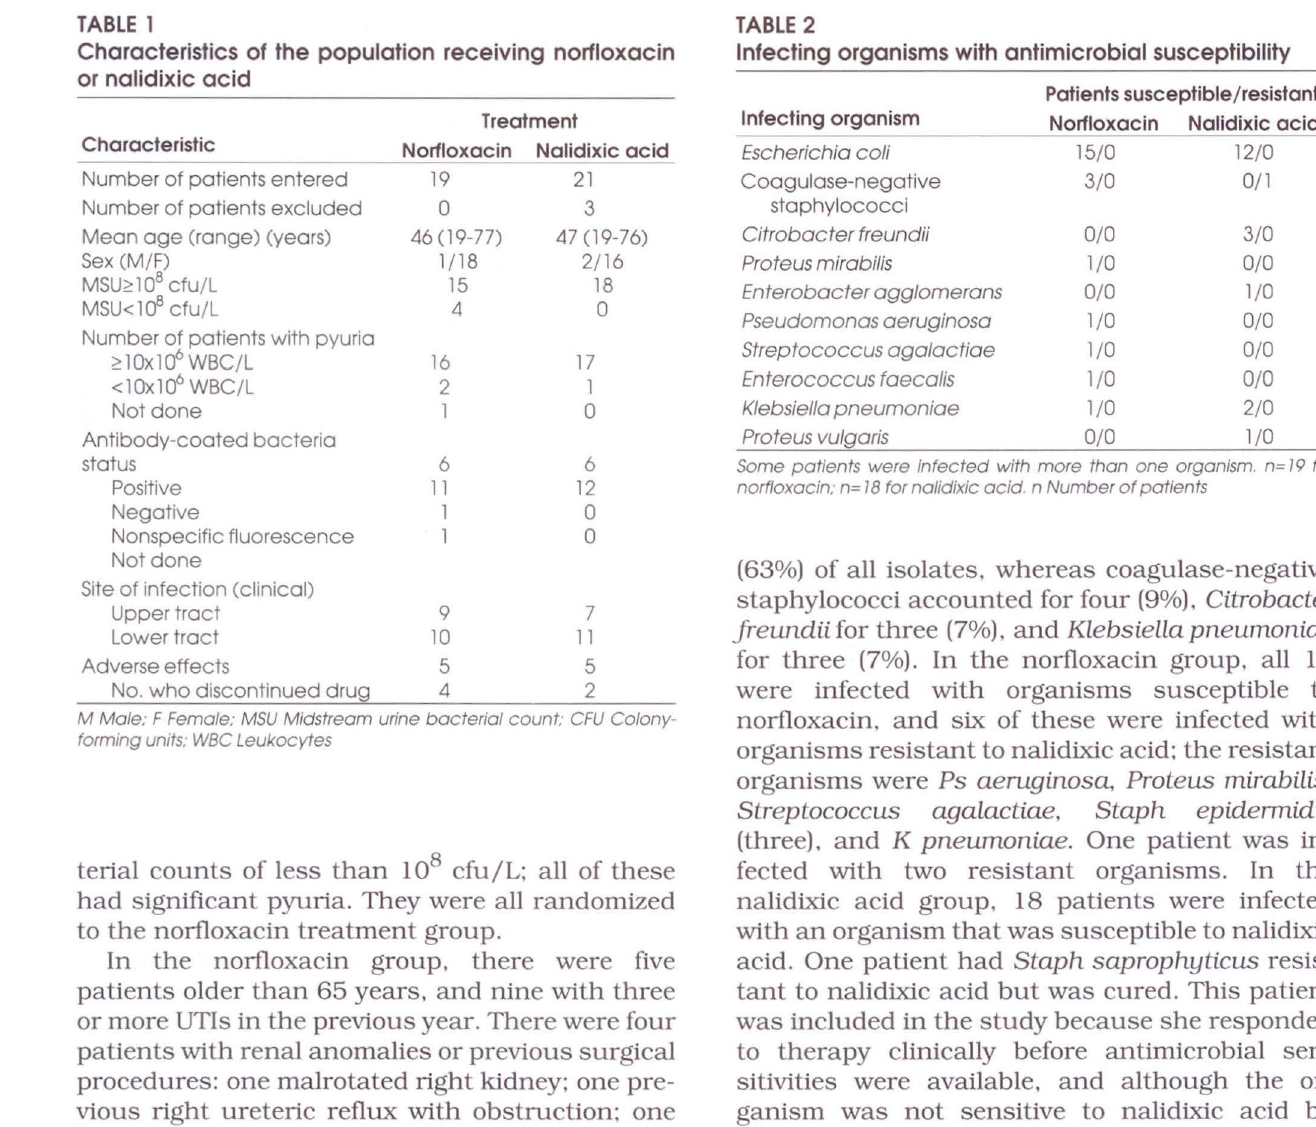
Patients susceptible/resistant Infecting